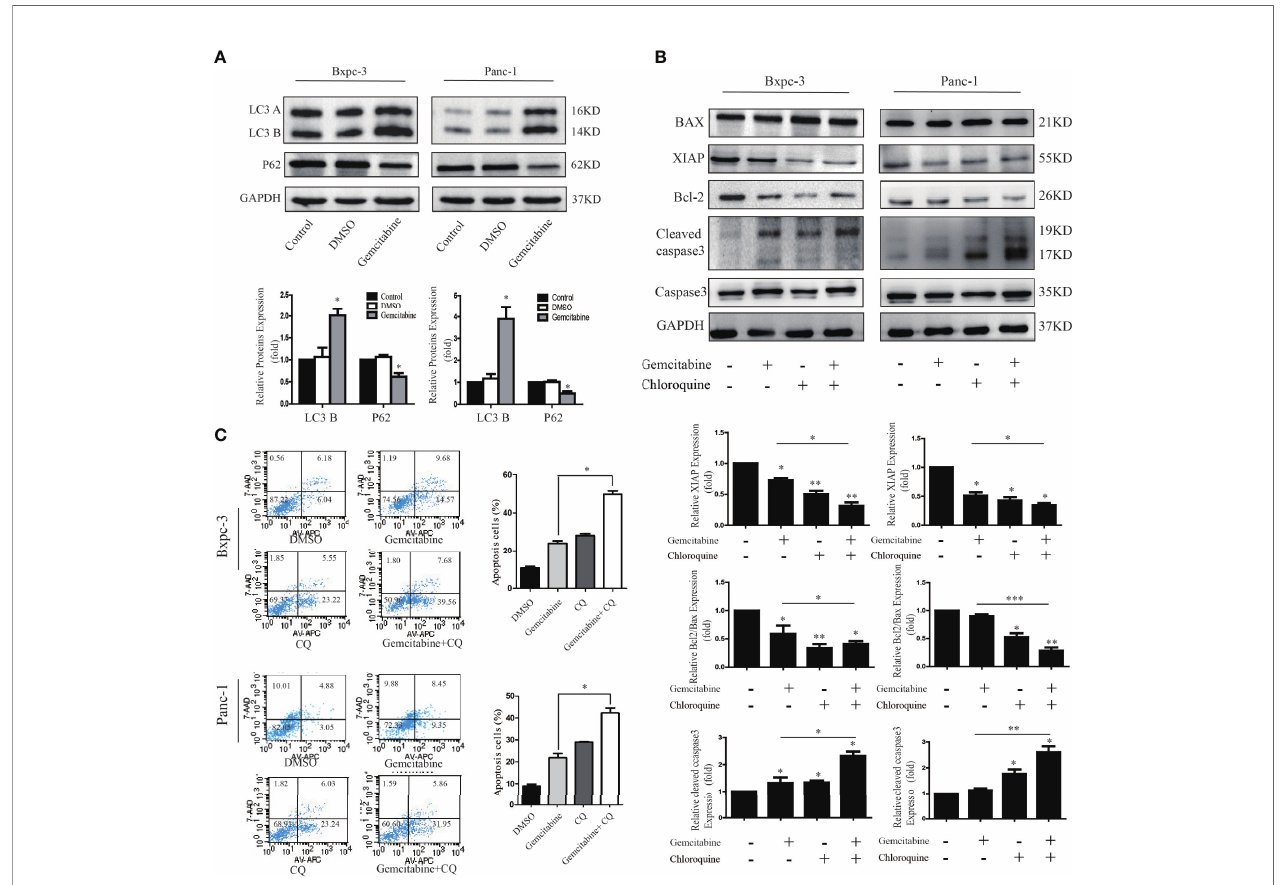
FIGURE 6 | Decreased autophagy activity can increase gemcitabine chemosensitivity to pancreatic cancer cells. (A) Autophagy related proteins LC3 and P62 were detected by western blotting after cells were treated with gemcitabine. (B) Apoptosis related proteins were detected by western blotting after cells were treated with single Chloroquine (CQ) or gemcitabine, and combination of the two. The combination treatment could down-regulate the Bcl-2/Bax ratio, XIAP and activate caspase-3. (C) Flow cytometry was performed using Bxpc-3 and Panc-1 cells treated with gemcitabine+CQ, which signi fi cantly induced apoptosis compared with single usage in pancreatic cancer